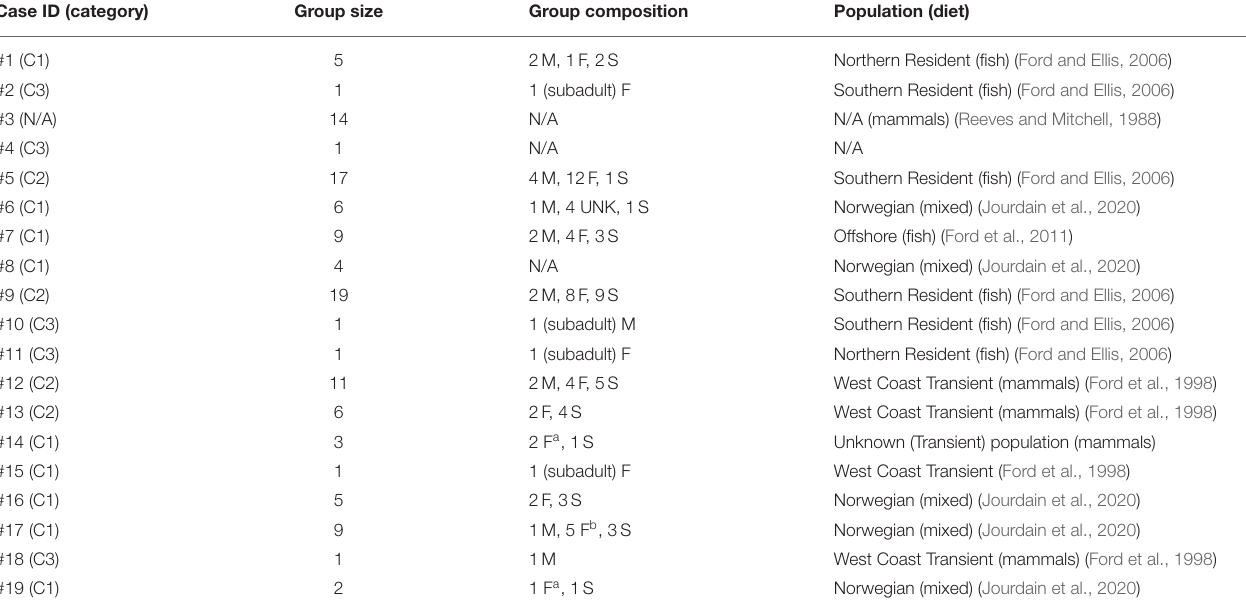
TABLE 2 | Characteristics of the killer whale groups and individuals (M: adult male, F: adult female, S: subadult of unknown sex, UNK: individuals of undetermined sex and age-class) that have become entrapped in the 19 cases recorded in 1949–2019 and included in this study.